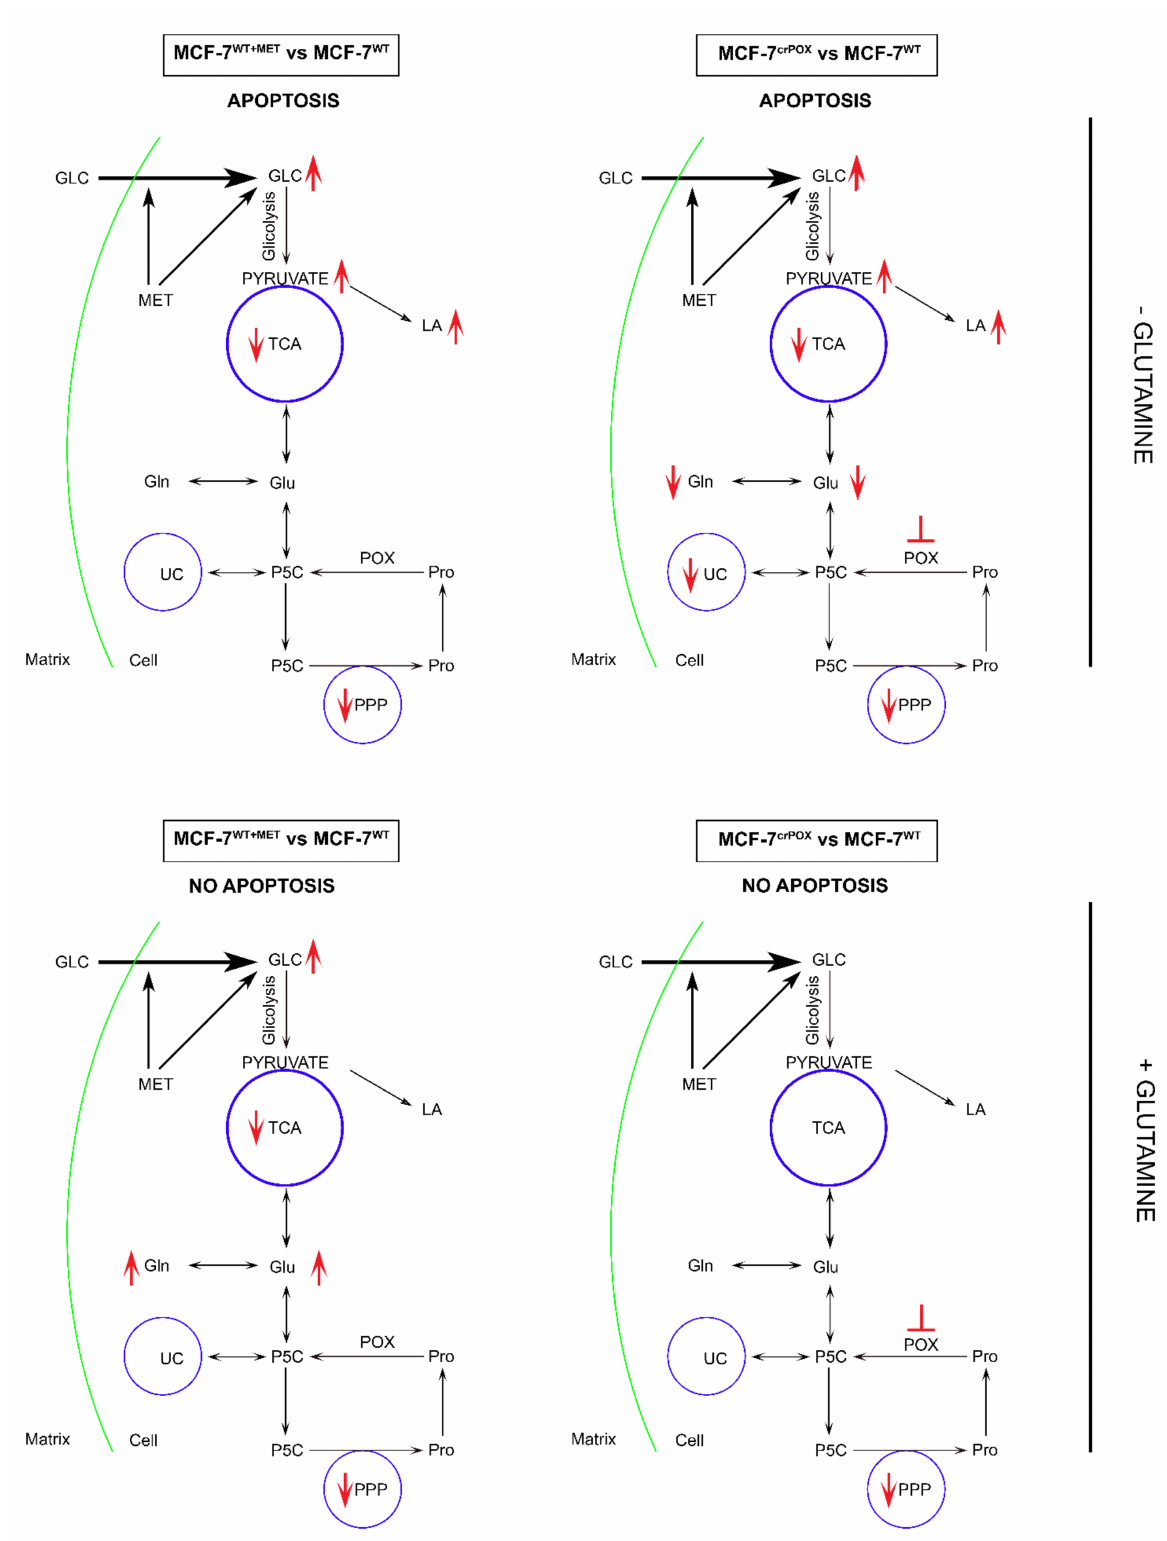
Figure 3. The functional significance of metformin (MET) and PRODH/POX knock-down on complex regulatory mecha- nisms driving PRODH/POX-dependent apoptosis/survival in wild-type MCF-7 cells (MCF-7 WT ) and PRODH/POX-knock out MCF-7 cells (MCF-7 crPOX ), cultured in the presence or absence of Gln. crPOX—CRISPER for POX, GLC—glucose, Gln-glutamine, Glu- glutamic acid, LA—lactate dehydrogenase, Pro—proline, POX—proline dehydrogenase/oxidase, PPP—pentose phosphate pathway, P5C—1-pyrroline-5-carboxylate, TCA—tricarboxylic acid cycle, UC—urea